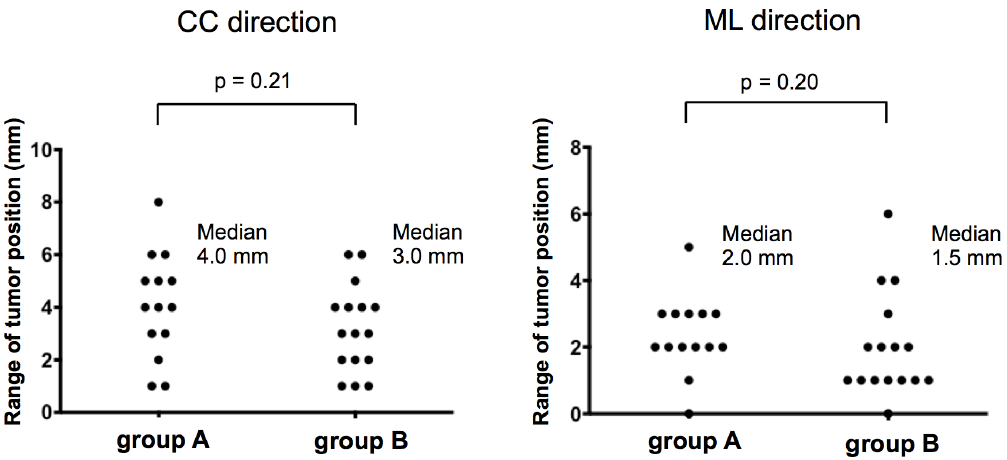
Figure 5. Range of the tumor position on electronic portal imaging device (EPID) images. Each point represents a single patient’s range of the tumor position during all treatment sessions. CC = craniocaudal; ML = mediolateral.